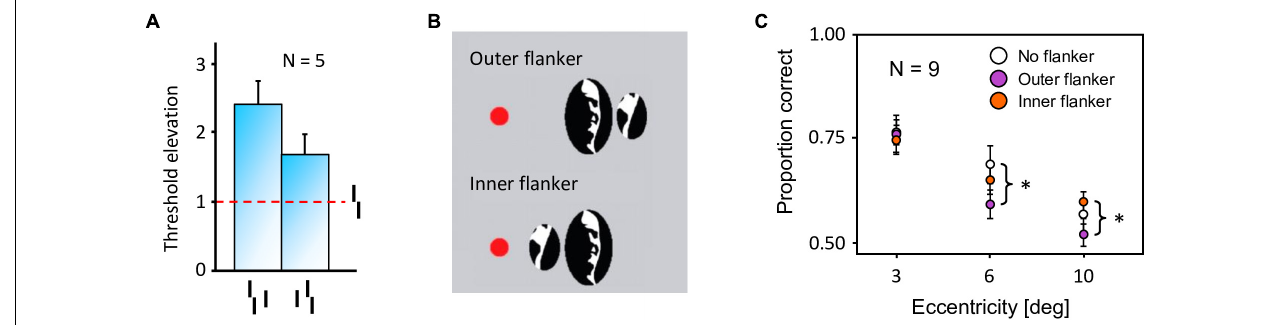
FIGURE 3 | Inward-outward anisotropy in visual crowding. (A) Inward-outward anisotropy in a Vernier discrimination task (experiment 1b of Manassi et al., 2012). Observers performed the Vernier discrimination task as presented in Figure 2A . The stimuli were always presented in the right visual field. The y -axis shows the target-offset threshold elevation, which is defined as the threshold of the condition divided by the threshold of the unflanked condition. Stronger crowding is observed for an outer flanker than for an inner flanker. (B) Stimuli used in the crowding paradigm of experiment 5 of Farzin et al. (2009), measuring inward-outward anisotropy with Mooney faces. The red dot is the fixation point. In this paradigm, the target Mooney face is shown either in the left or the right visual hemi-field, together with either an inner flanker, an outer flanker, or with no flanker and at different eccentricities of 3 ◦ , 6 ◦ , and 10 ◦ (one block per eccentricity and per flanker configuration). Observers were asked to discriminate an upright from an inverted target Mooney face (2-AFC discrimination task). (C) Data from experiment 5 of Farzin et al. (2009). Note that the y -axis is the proportion of correct discrimination, and that a high value means a good discrimination performance. The stars indicate significant differences between conditions. The amount of inward-outward anisotropy (how much the inner-flanker condition produces better performance than the outer-flanker condition) interacts with the stimulus eccentricity.